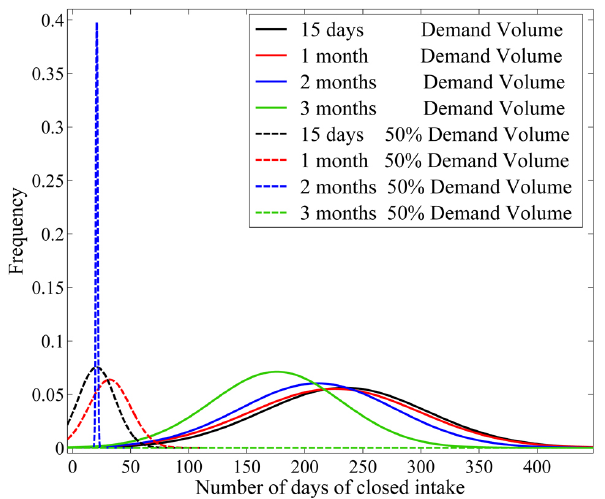
Fig. 5b. Function of probability of the number of days of closed urban supply intake in a ten-year